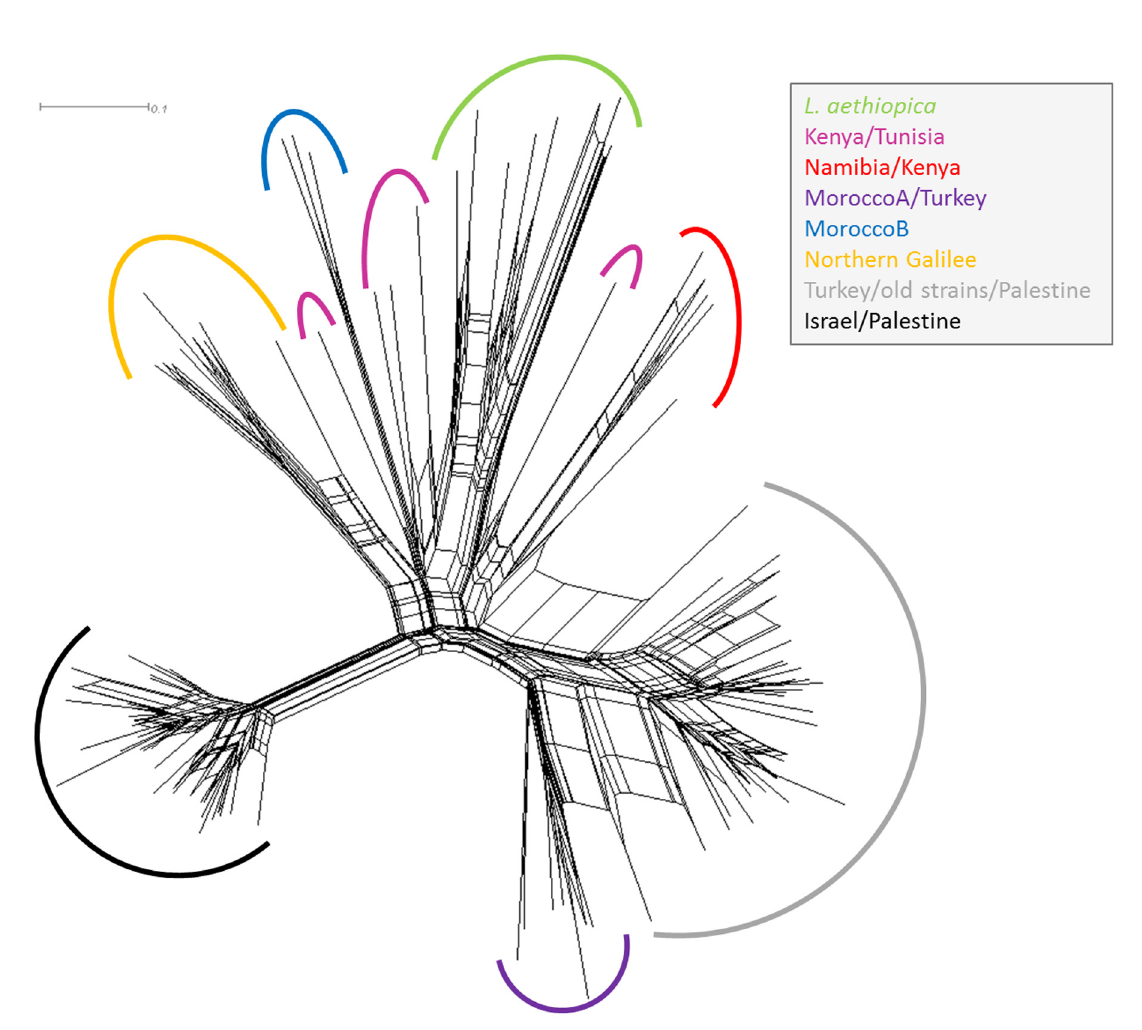
Fig 2. Network presenting the genetic relationship between strains of L . aethiopica and L . tropica . Cross connections indicate probable reticulation events like hybridisation, recombination and horizontal gene transfer between the strains. The sub-populations within the population Africa/Galilee resulting from clustering based on Bayesian statistical results are in different colours; the main populations Turkey/old strains/Palestine and Israel/Palestine are highlighted in grey and black, respectively.